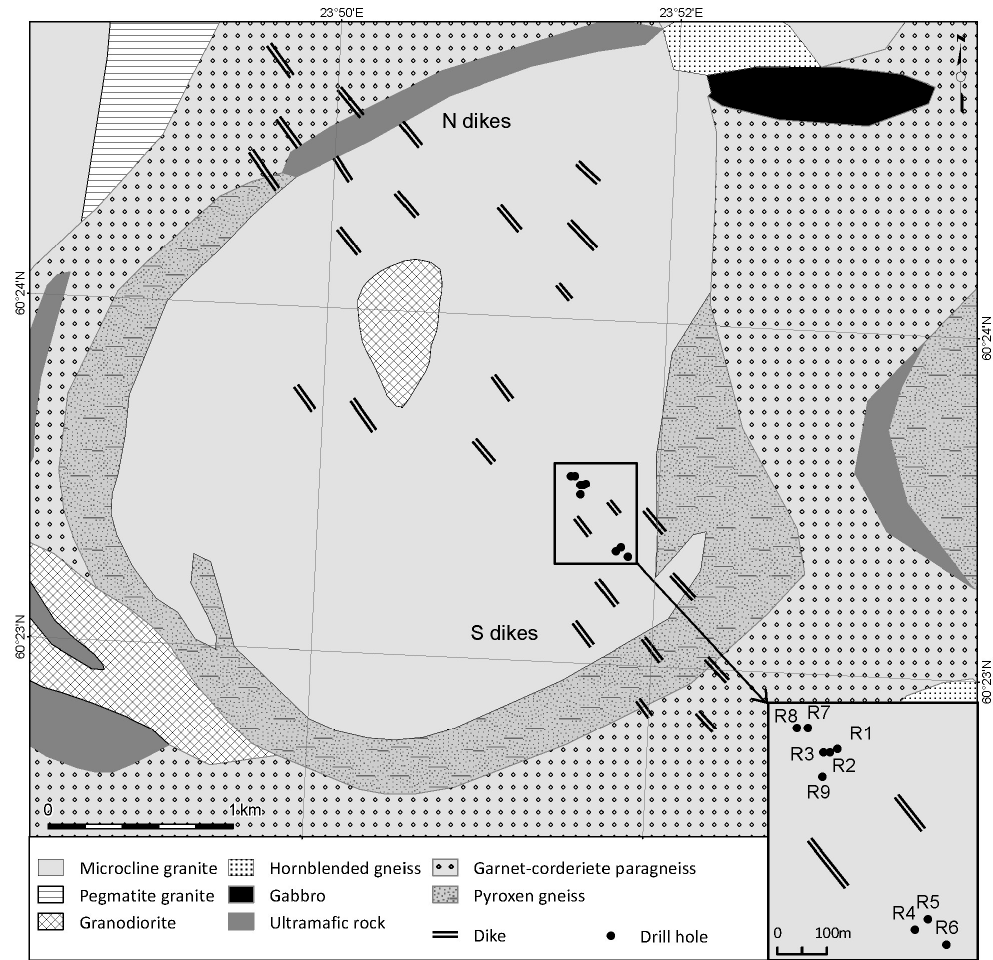
Figure 16. Geological sketch map showing the major lithological units of the Kovela granitic complex in southern Finland (also see Figure 1) on the basis of the electronic map sheet in the DigiKP database of the Geological Survey of Finland. Coordinates are given according to the Finnish National Coordinate System ETRS-TM35FIN.